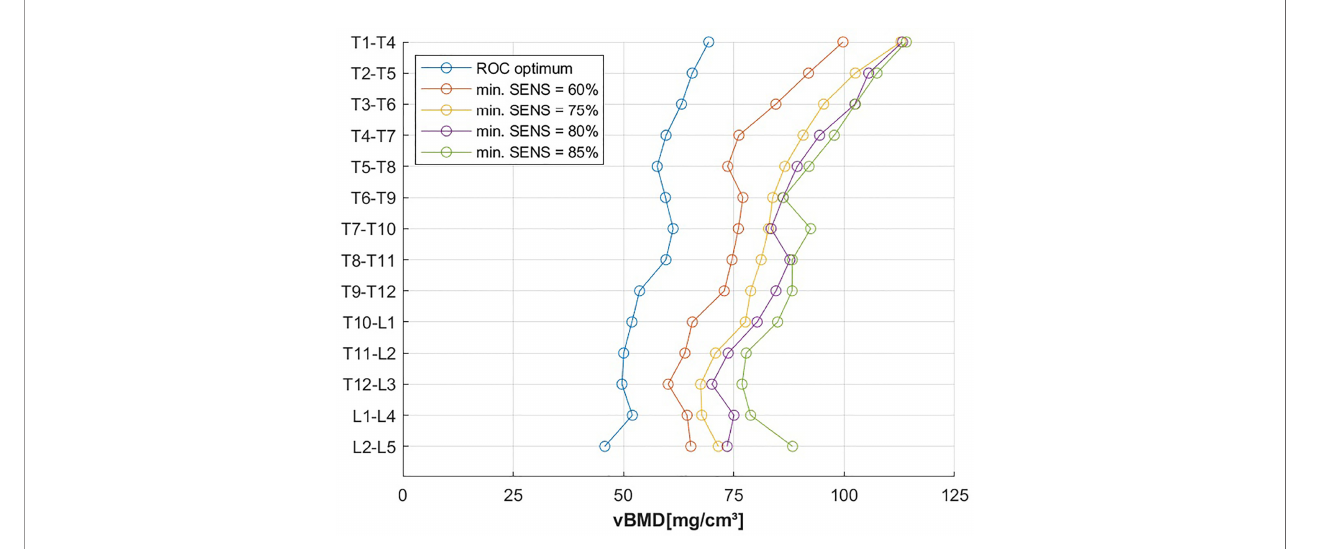
FIGURE 4 | vBMD threshold, grouped by vertebral height for optimal operating point of the ROC curve and fi xed minimal sensitivity values (min. SENS).